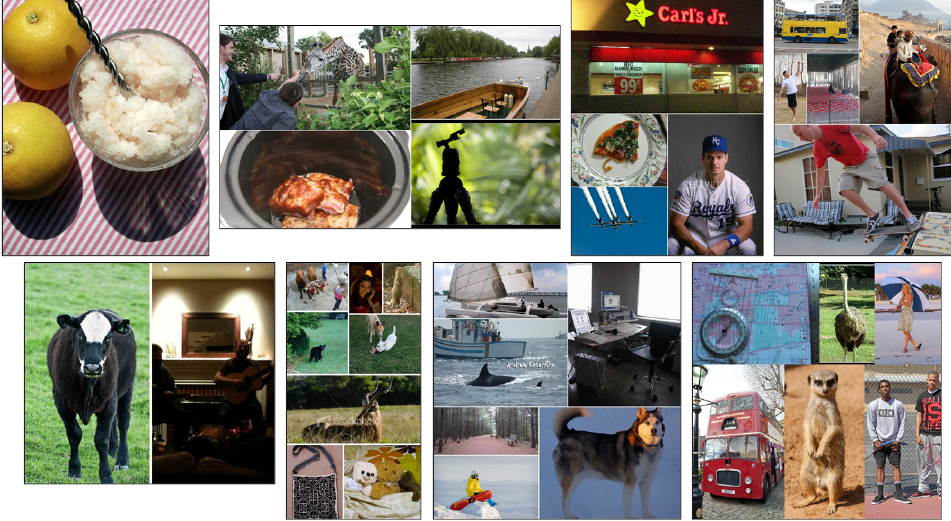
Figure 10. Samples from the image collage dataset. The collages are generated according to random partition